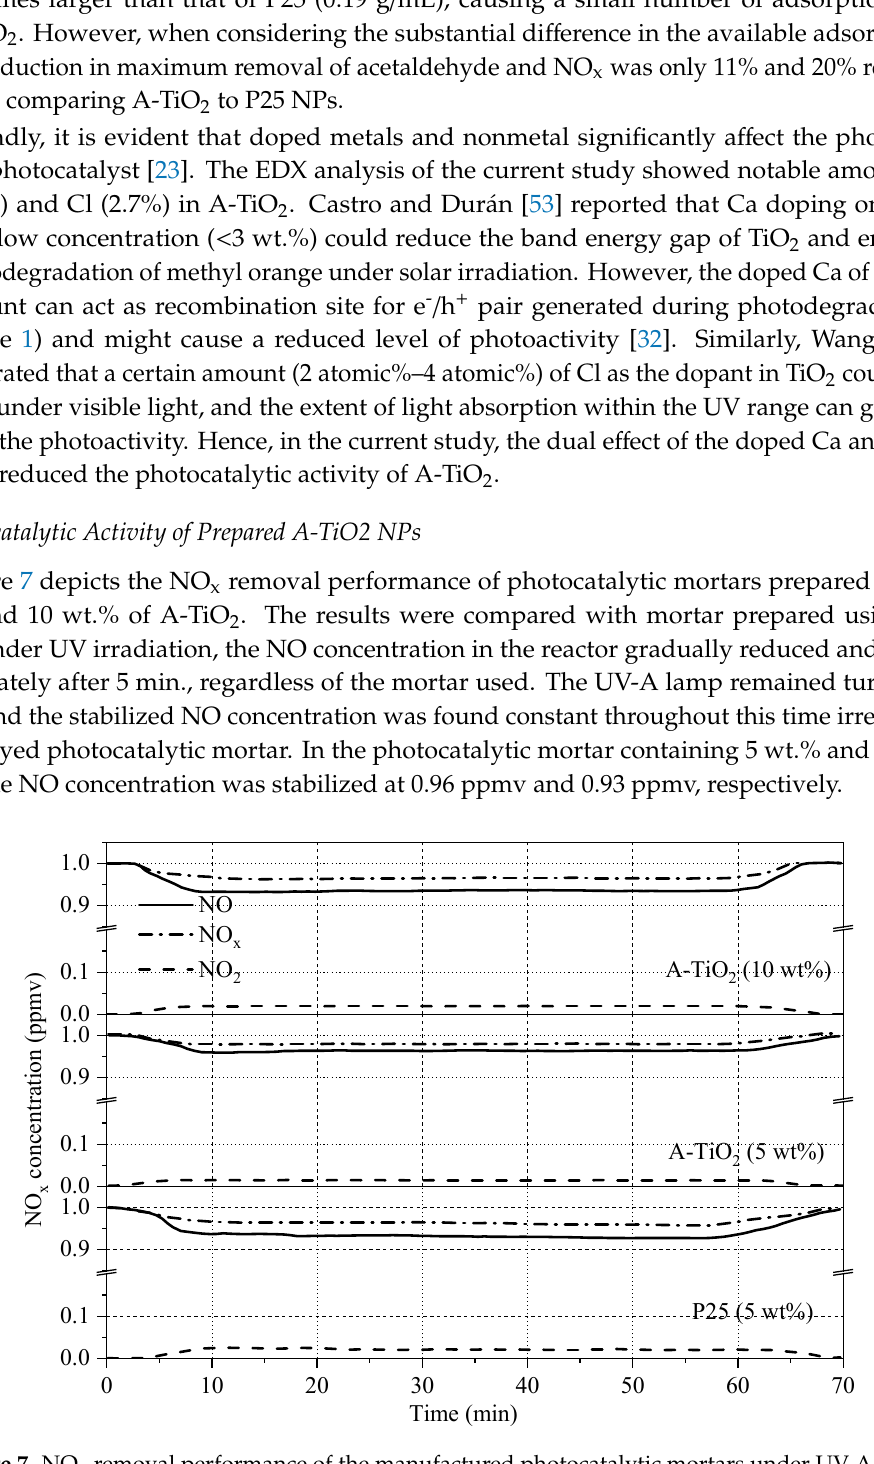
Figure 7. NO x removal performance of the manufactured photocatalytic mortars under UV-A lamp.